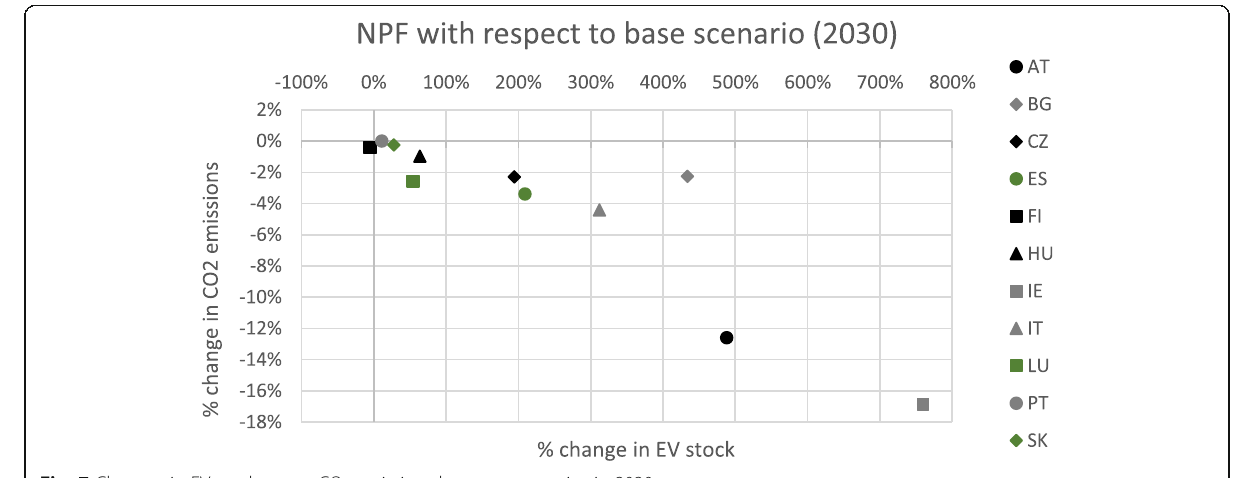
Fig. 7 Changes in EV stock versus CO 2 emissions between scenarios in